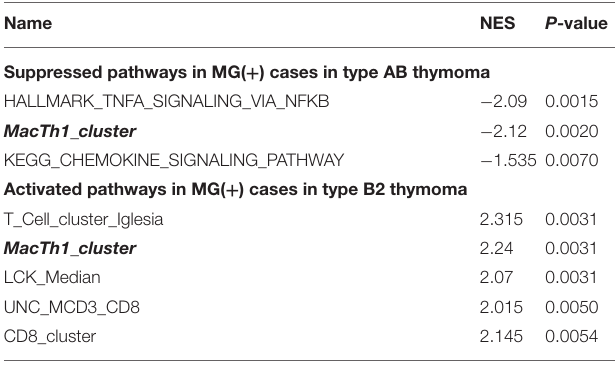
TABLE 2 | Upregulated or downregulated “immune” pathways in myasthenia gravis